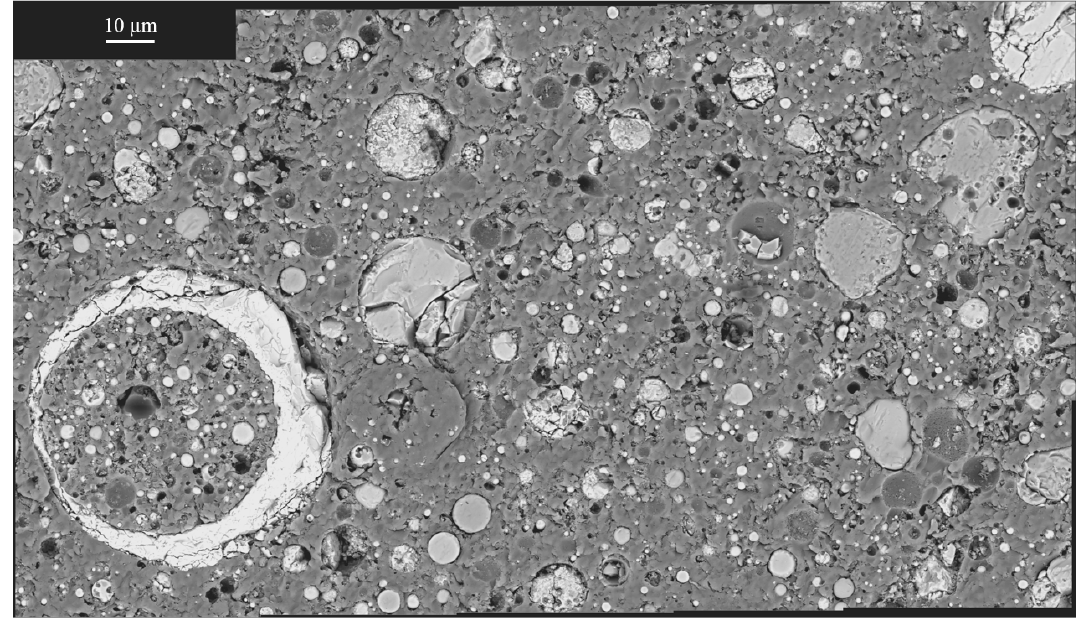
are extraneous to the sample.